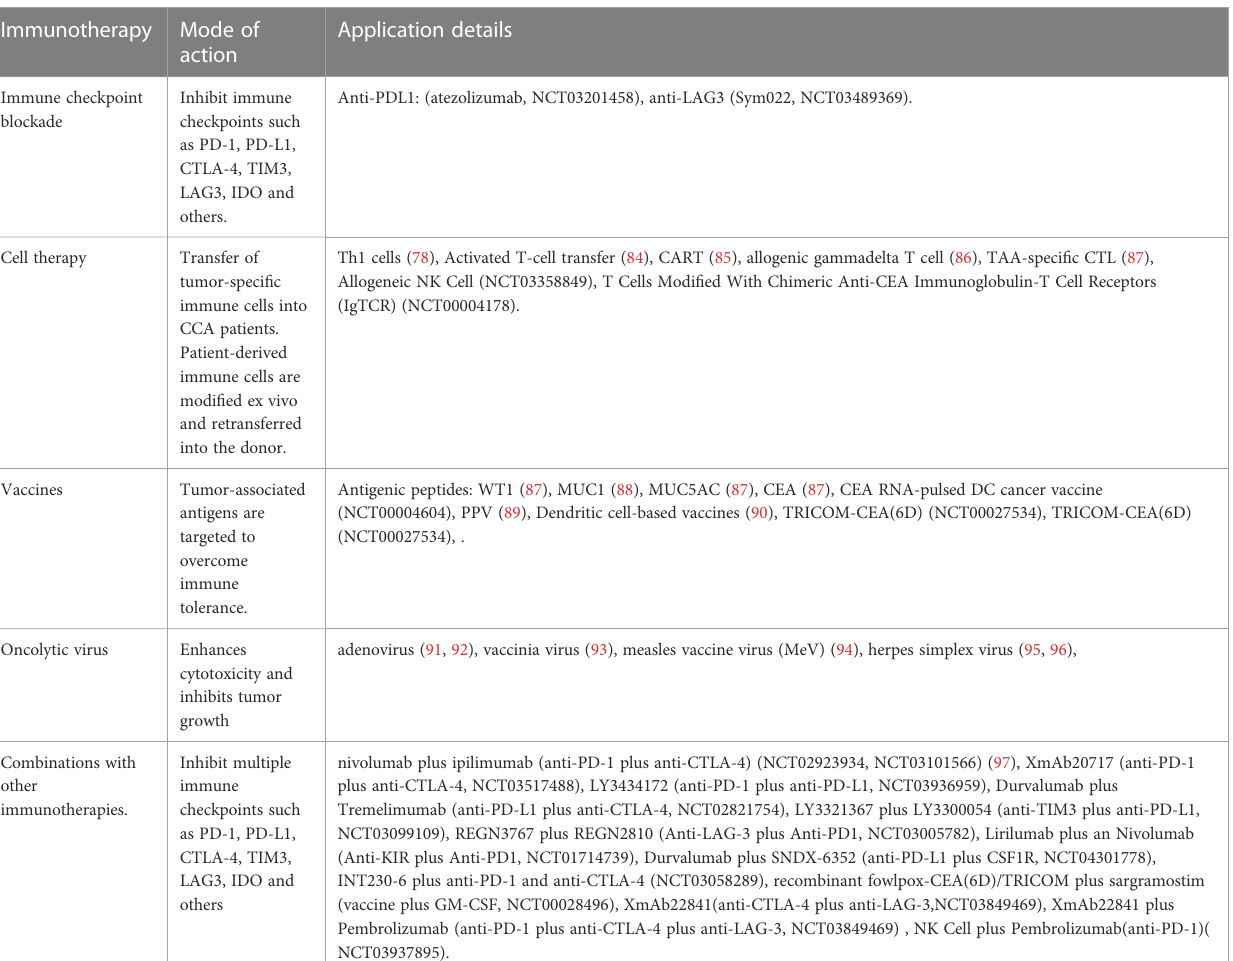
TABLE 2 Current immunotherapeutic strategies to treat